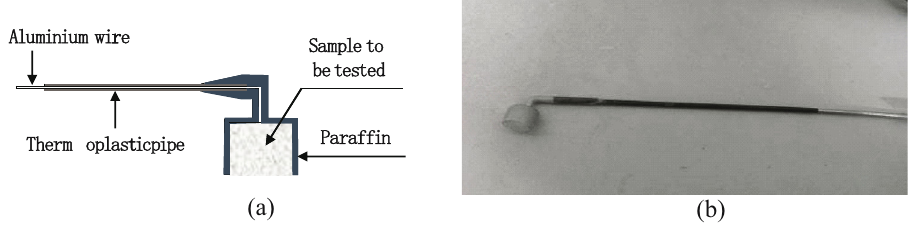
Figure 4: Working electrode and its structure diagram: ( a ) electrode structure and ( b ) working electrode.